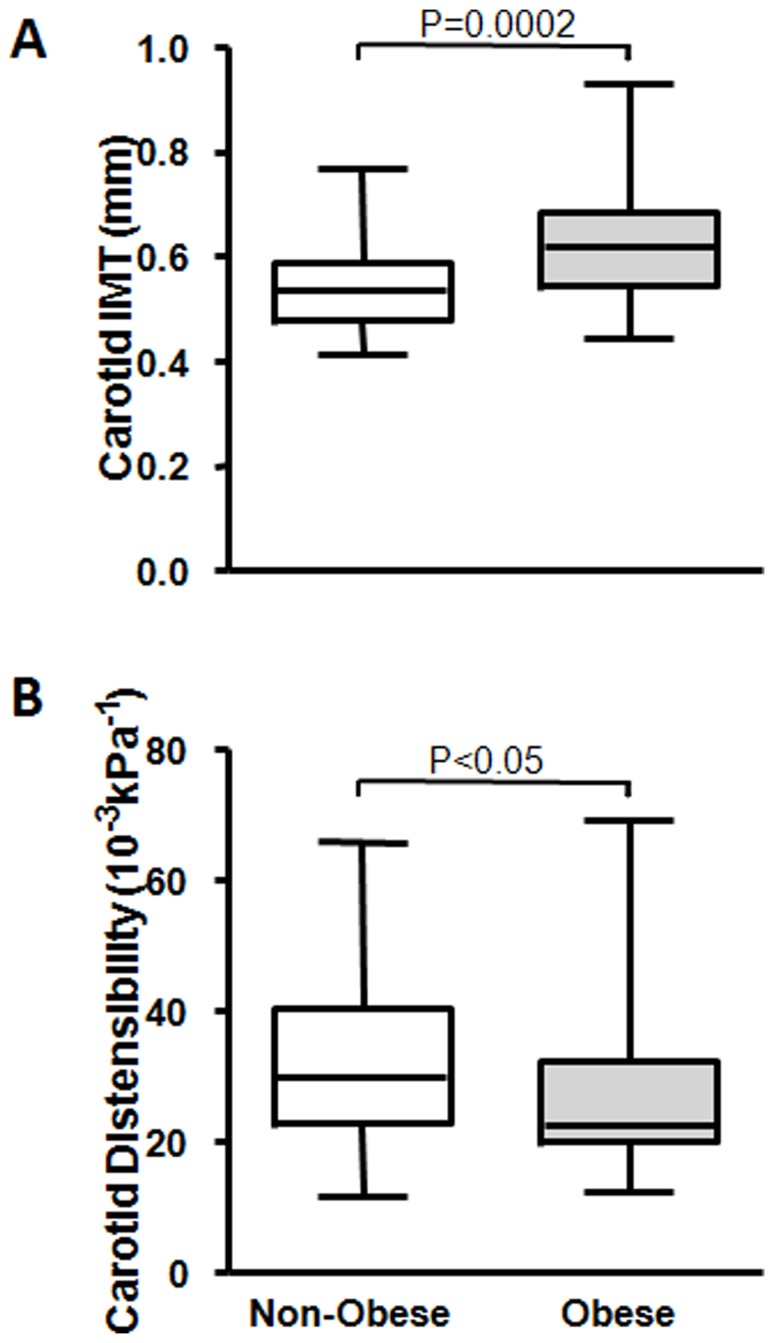
Increased cIMT (A) and reduced distensibility (B) in obesity.Median, minimum and maximum values of cIMT and distensibility.